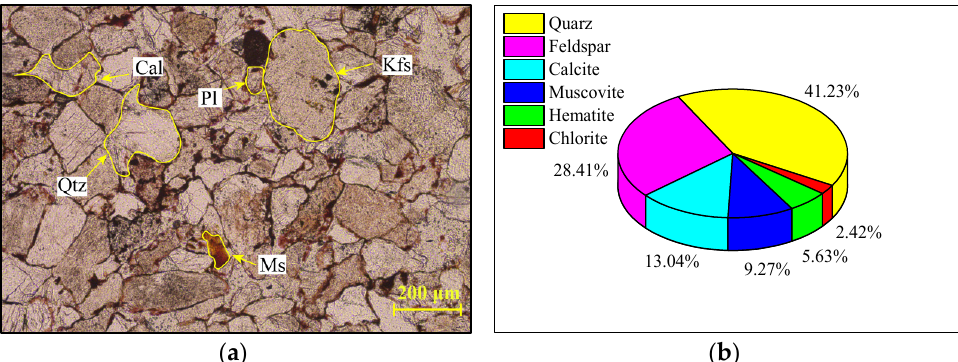
Figure 1. Mineral composition: ( a ) optical microscope image of sandstone and ( b ) content of minerals. (Qtz-quartz; Kfs-Potash feldspar; Pl-plagioclase; Cal-calcite; Ms-muscovite).